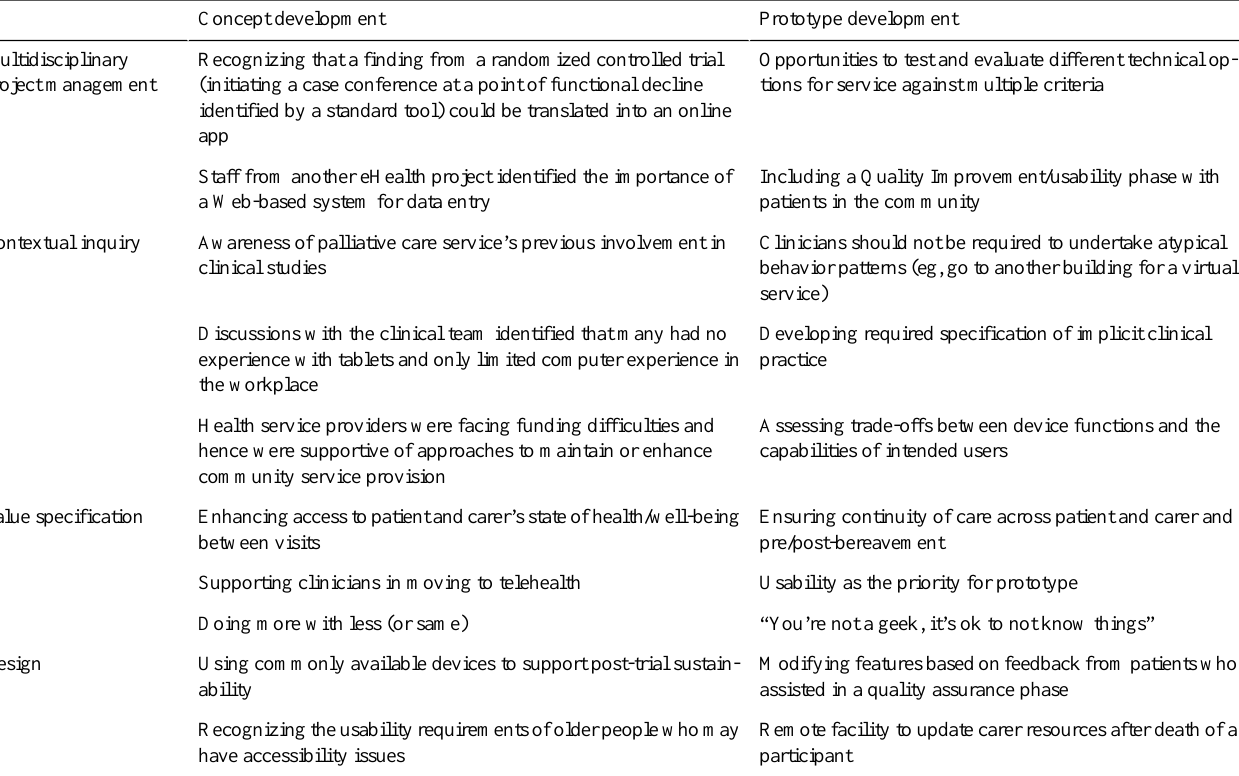
Table 1. Examples of how inputs associated with research and development activities affected telehealth